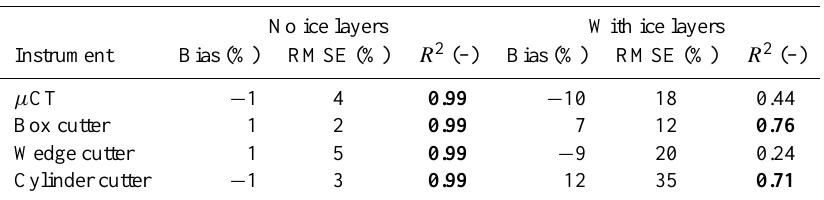
Figure 3. Density profile measured by different methods. Two methods each are displayed separately for better visibility. Note that the cylinder profile shows the density with respect to the stratigraphic layers. Table 6. Comparison of the field measurements with the mean layer densities (Fig. 5), expressed in% of the mean layer densities. Significant agreement ( p val < 0 . 01) is indicated by bold